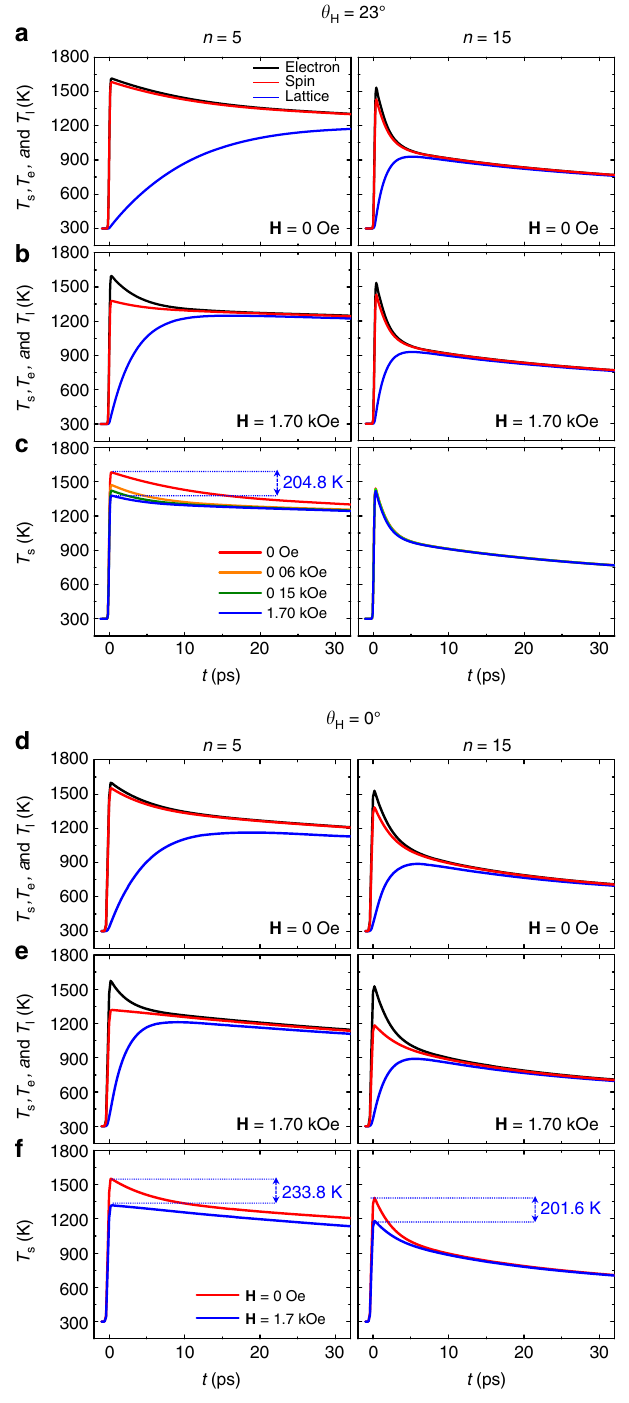
Fig. 3 Temperatures of electron, spin and lattice. Temporal behavior of T s (red), T e (black) and T l (blue) determined from 3TM analysis for n = 5 (left) and 15 (right) with θ H = 23° a under a zero fi eld and b external fi eld of 1.70 kOe. c T s with respect to the delay for various fi elds of H between 0 and 1.70 kOe. T s (red), T e (black) and T l (blue) determined from 3TM analysis for n = 5 (left) and 15 (right) with θ H = 0° ( d ) under a zero fi eld and ( e ) external fi eld of 1.70kOe. ( f ) T s with respect to the delay for H = 0 and